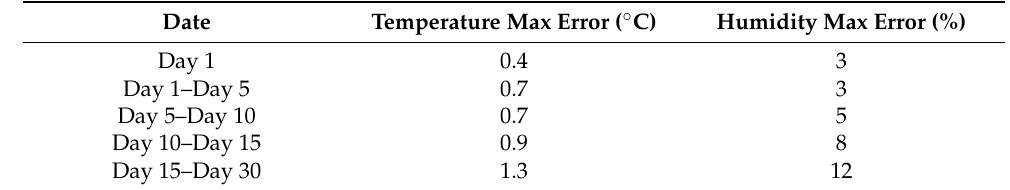
Table 3. The maximum error of temperature and humidity in different time periods.